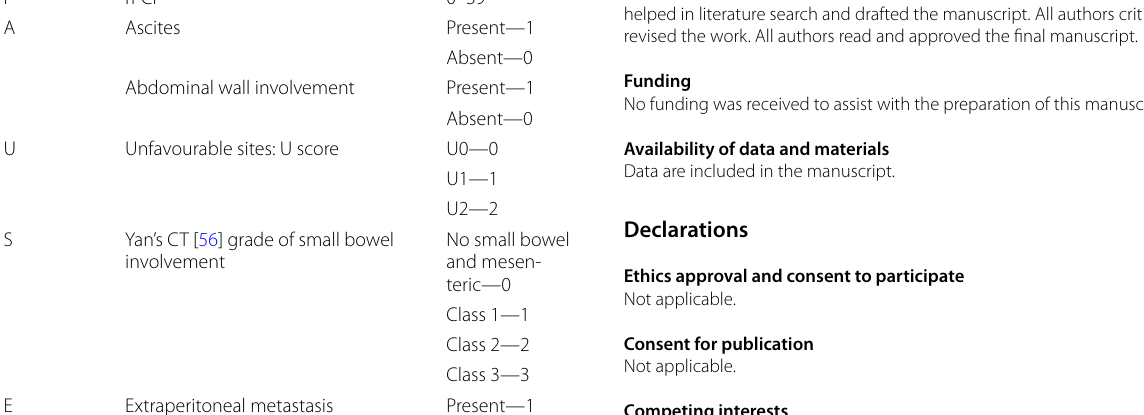
Table 2 Simplified scoring system to communicate imaging findings in peritoneal malignancy using the concept of ‘PAUSE’ PAUSE